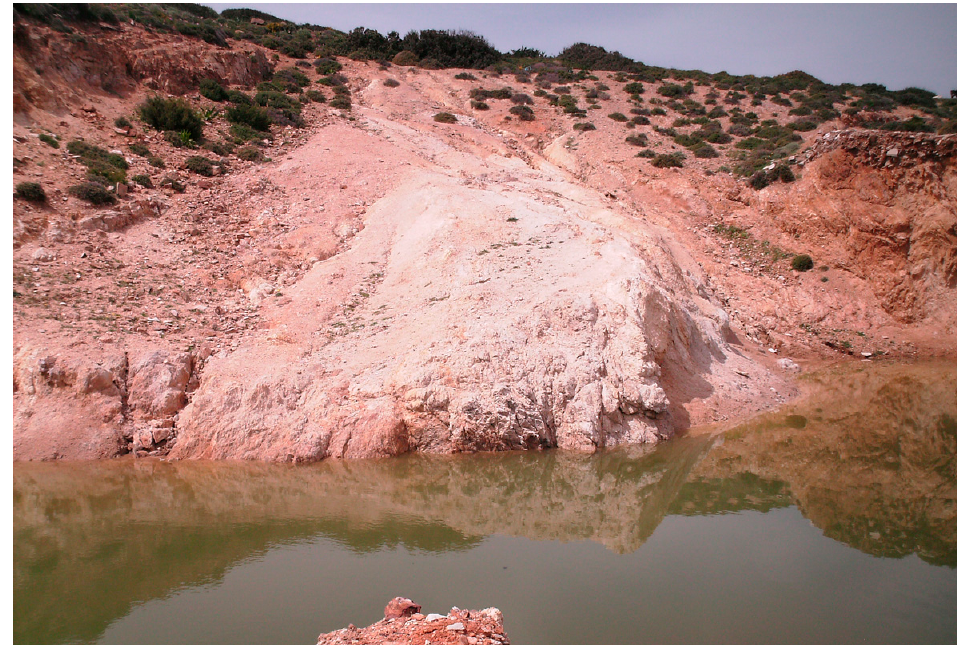
Figure 3. Field photo from the hydrothermal alteration zone presented in Figure 2 (area 4).